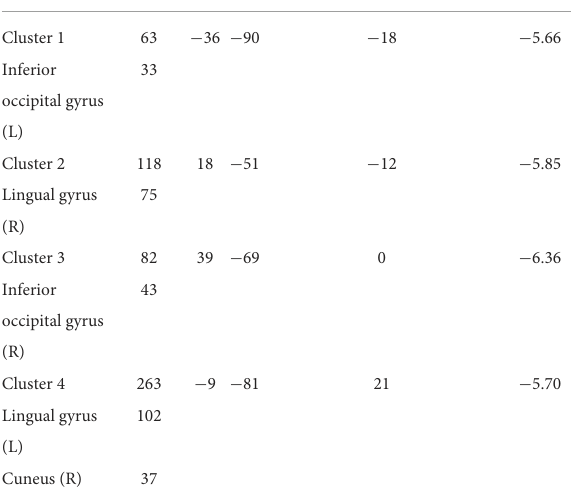
TABLE 4 Brain regions with abnormal fALFF in patients with